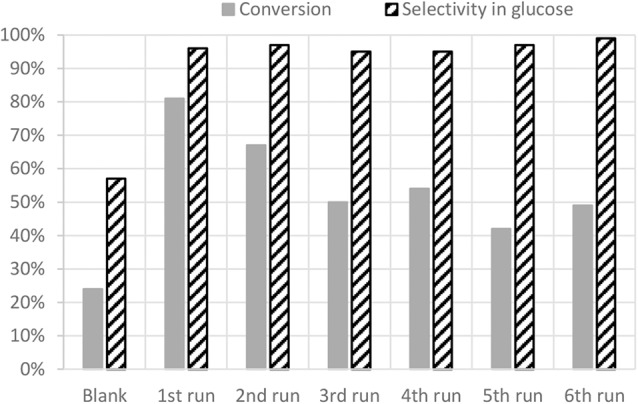
Recyclability of SO3H/SX+ catalyst.